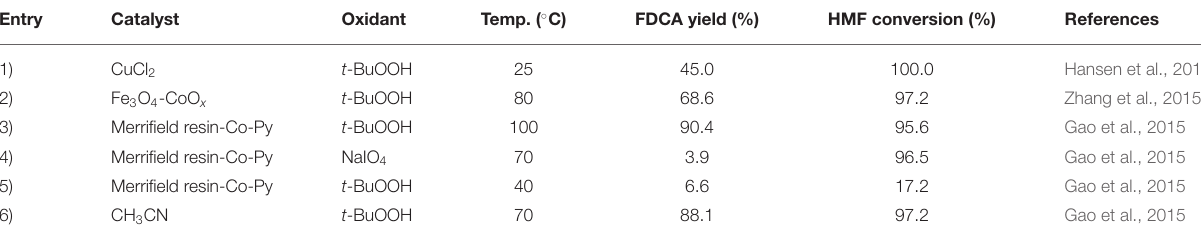
TABLE 5 | HMF oxidation processes to FDCA by using other